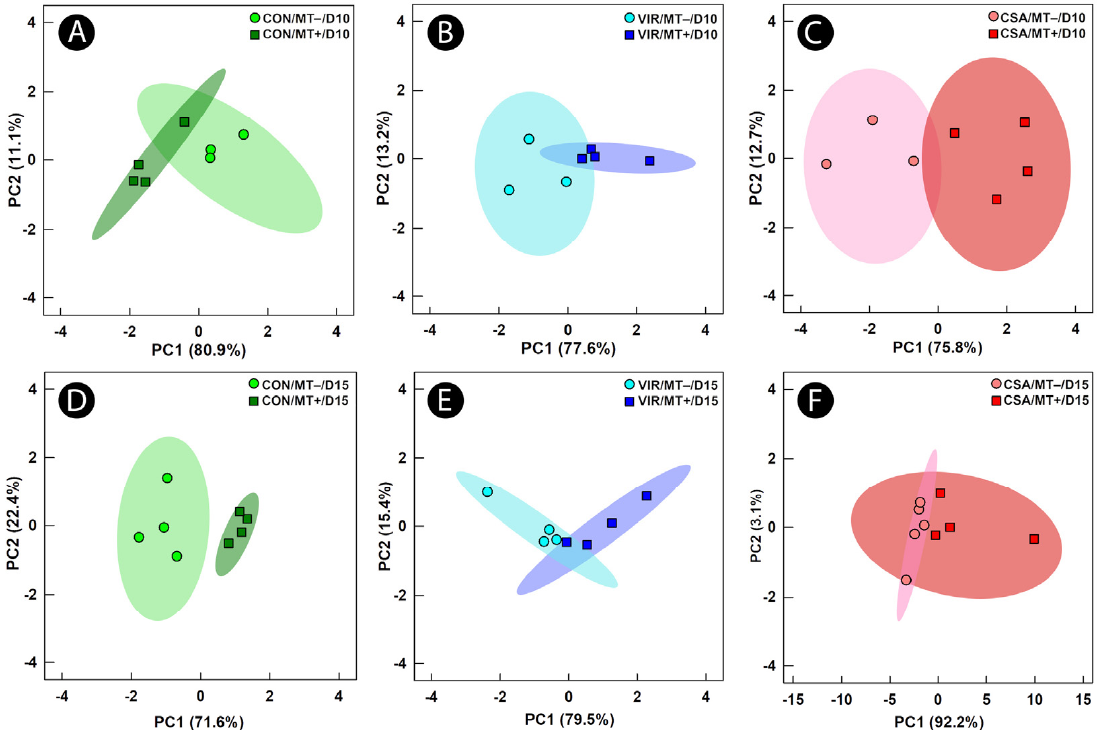
Figure 3. Principal component analysis score plots of metabolites bins in cecal digesta of broiler chicks administered an unamended starter diet (CON), a diet supplemented with virginiamycin (VIR), or a diet supplemented with the ceragenin, CSA-44 (CSA). Birds received a microbiota transplant (MT+) or buffer alone (MT–), and samples were obtained 10 days post-hatch (D10) and 15 days post-hatch (D15). Each marker represents one bird, and the shaded ellipses represent 95% confidence intervals. The x- and y-axes show principal components one and two, respectively, with the number in brackets indicating the percent variance of each component. Metabolite bins were determined to differ ( p ≤ 0.050) according to a univariate Mann–Whitney U-test. ( A ) CON/MT– vs. CON/MT+ at day 10; ( B ) VIR/MT– vs. VIR/MT+ at day 10; ( C ) CSA/MT– vs. CSA/MT+ at day 10; ( D ) CON/MT– vs. CON/MT+ at day 15; ( E ) VIR/MT– vs. VIR/MT+ at day 15; ( F ) CSA/MT– vs. CSA/MT+ at day 15.